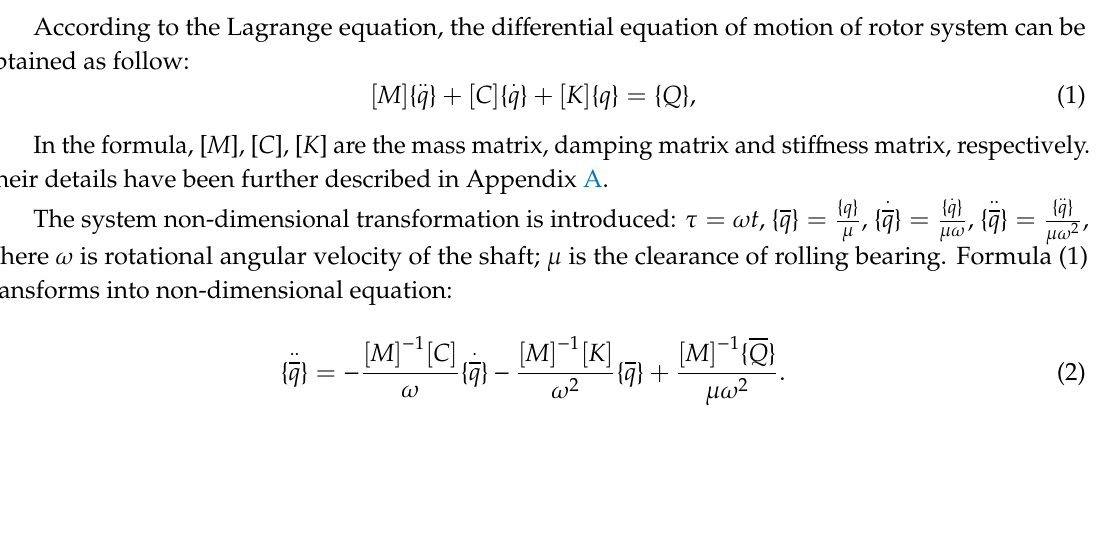
Figure 1. The simplified model of SFD-rotor-bearing system.